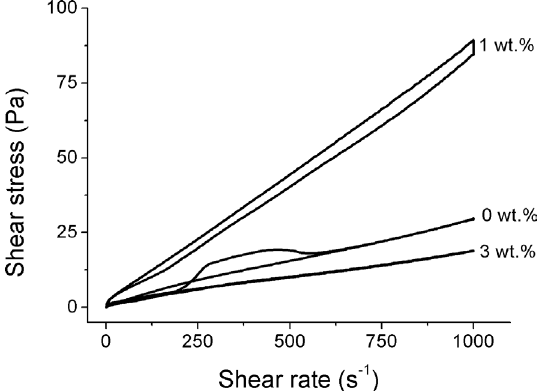
Figure 2. CR flow curves of aqueous copper suspensions to different weight concentrations of binder.